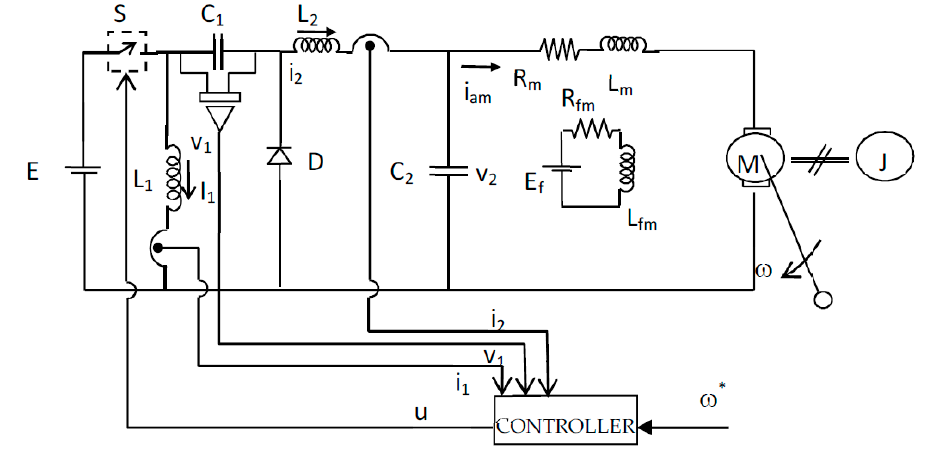
Figure 3. ETEDPOF control of a luo converter.